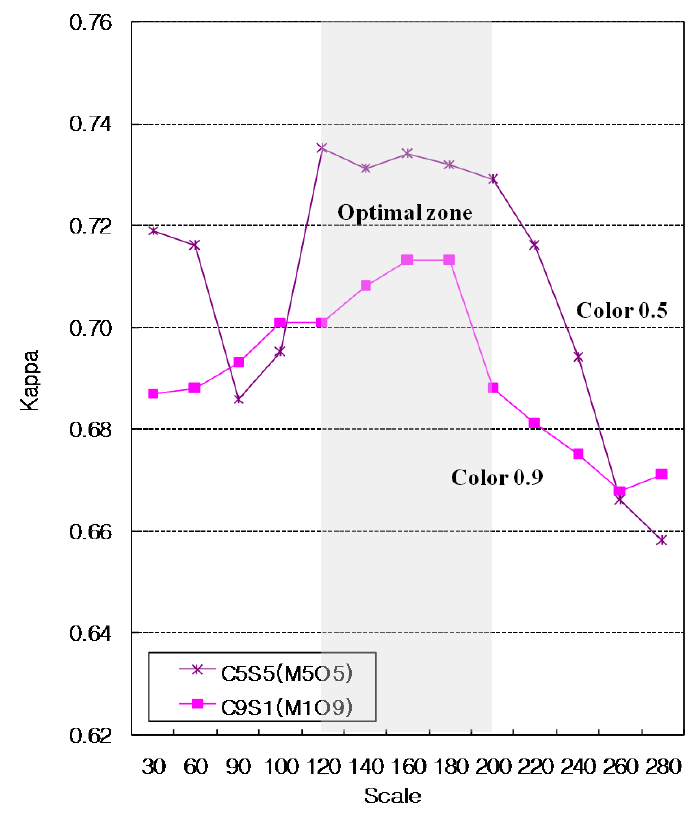
Figure 4. Optimal weights for